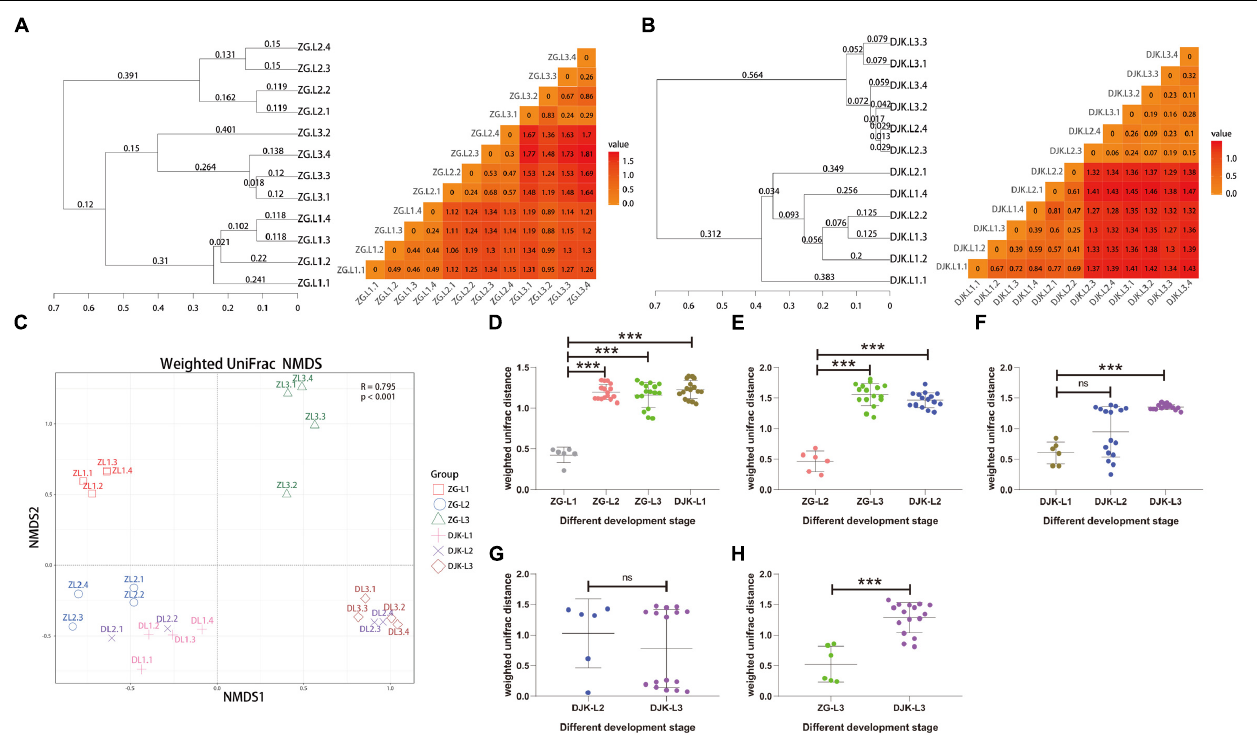
FIGURE 5 | Fungal community dissimilarity of two field populations based on UniFrac metrics. (A) UPGMA (left) and heatmap (right) analyses of the fungal community in the ZG population. (B) UPGMA (left) and heatmap (right) analyses of the fungal community in the DJK population. (C) NMDS analyses of all samples. Each symbol represents a sample, and different colors represent different development stages of larvae. Variation in communities segregated strongly according to host development stage and different field populations (PERMANOVA test with 999 permutations, P ≤ 0.001). (D–H) Weighted UniFrac distances between different development stages ( n = 6 ∼ 16). In each panel, the first entry in the X axis serves as the reference for the comparisons, and the median is plotted as a horizontal line. ∗∗∗ p < 0.001; ns, not significant as calculated by Student’s t